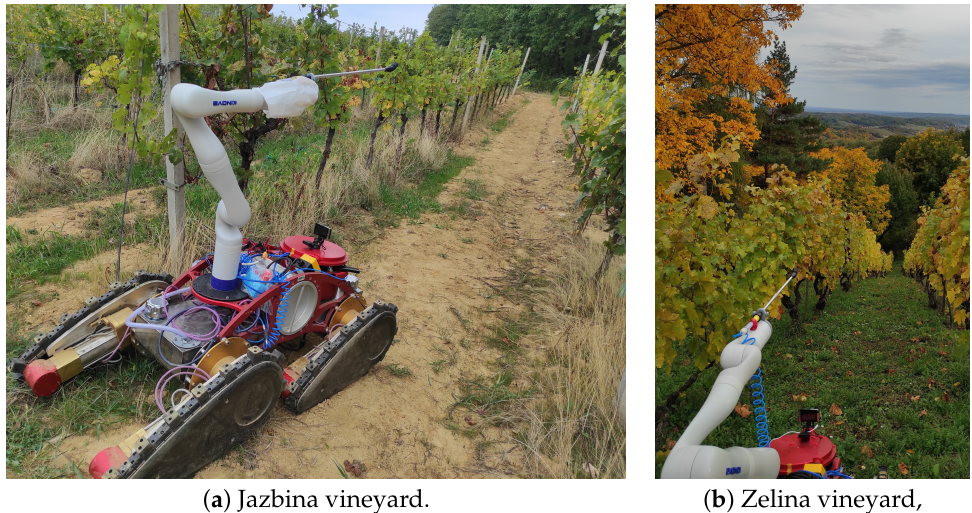
Figure 11. ATMM at the starting points before the experiments to measure power